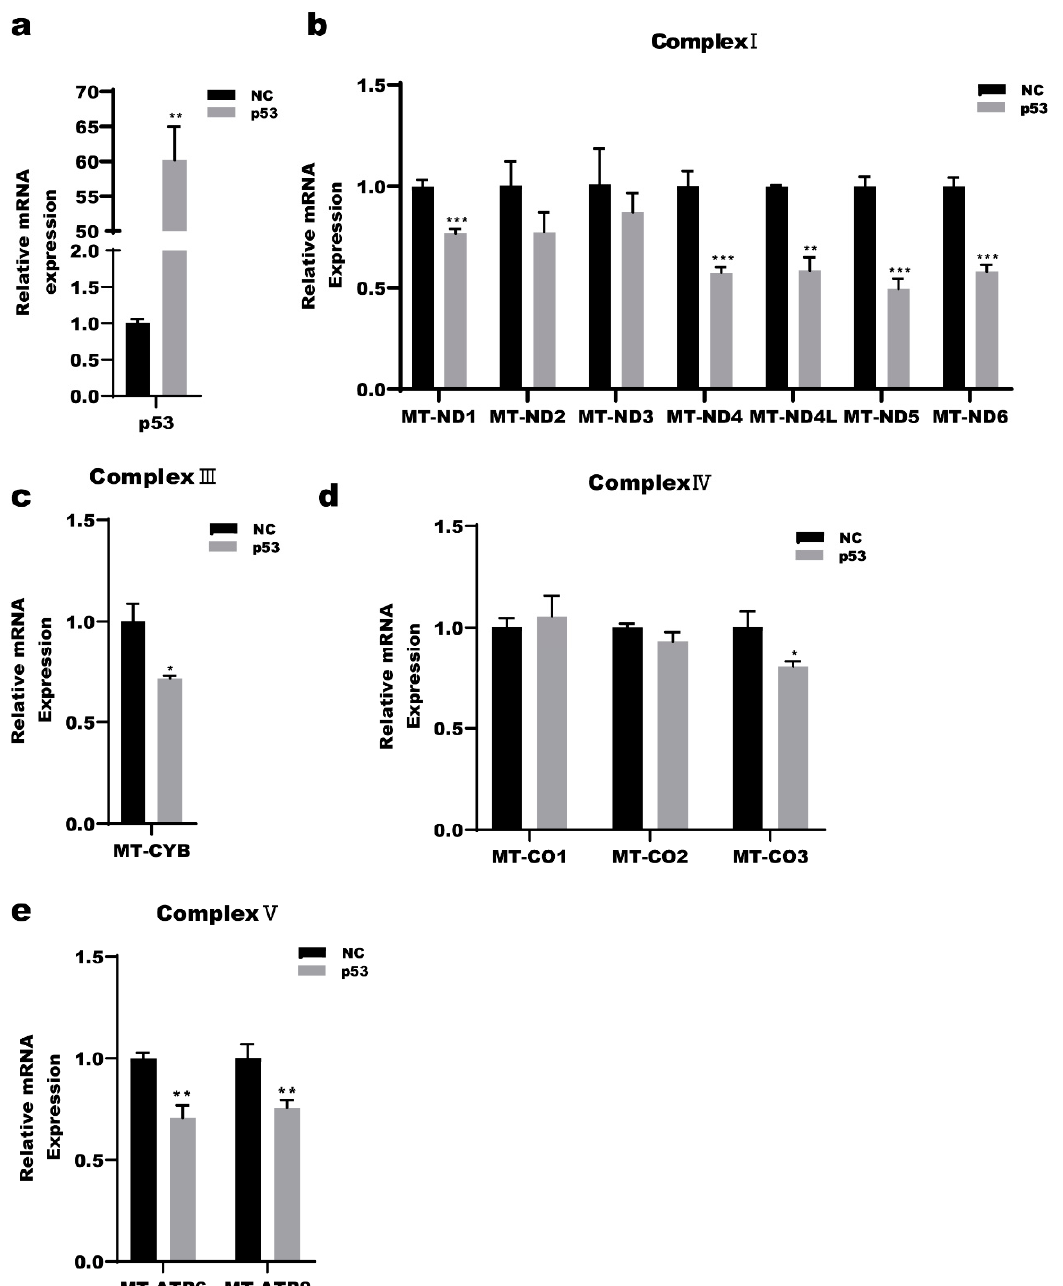
Figure 4. p53 is involved in the transcription respiratory chain subunits encoded by mtDNA. Wild- type p53 were transfected into A2780 cells for 24 h and total RNA were extracted. ( a ) Quantitative RT-PCR detection of the transfection efficiency of wild-type p53 transfected into A2780 cells. ( b – e ) Quantitative RT-PCR detection of mRNAs level of respiratory chain subunits encoded by mtDNA. * p < 0.05 vs. NC, ** p < 0.01 vs. NC, *** p < 0.001 vs. NC.